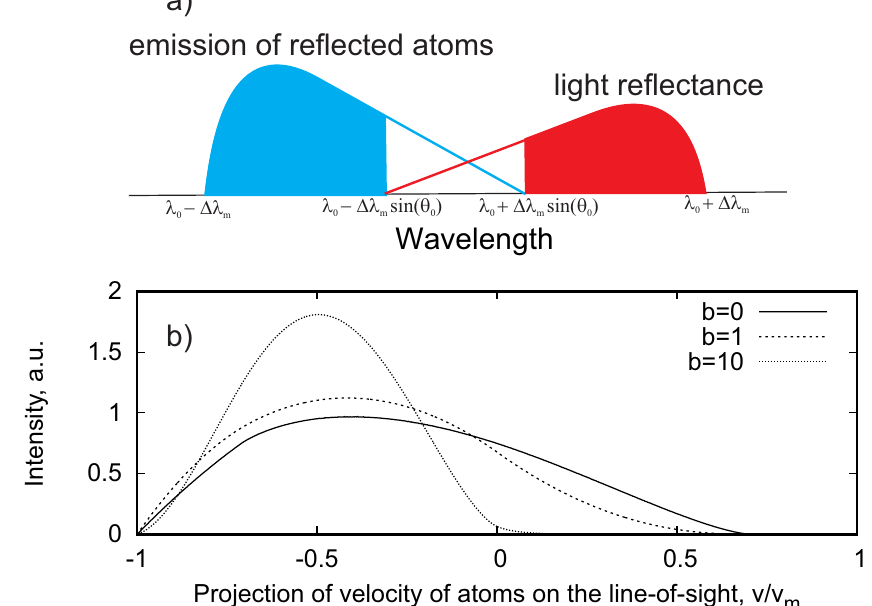
Figure 7. ( a ) Schematic picture of the emission of reflected atoms and light reflectance at the mirror surface ( θ 0 < 90 ◦ ). The emission of reflected atoms is shown using the blue curve and the signal caused by light reflectance at the mirror using the red curve. In case of specular reflectance the profiles must be symmetrical, and only the amplitude is reduced. ( b ) Simulated emission of reflected atoms (blue-shifted signal) at the observation angle of θ 0 = 45 ◦ as a function of the projection of normalized velocity on the line-of-sight, E m = mv 2 m /2. Here, the energy distribution function f ( E ) and the emission rate coefficient κ were assumed constant. The integral over the emission is independent on the parameter of angular distribution function b , but it also remains constant for different observation